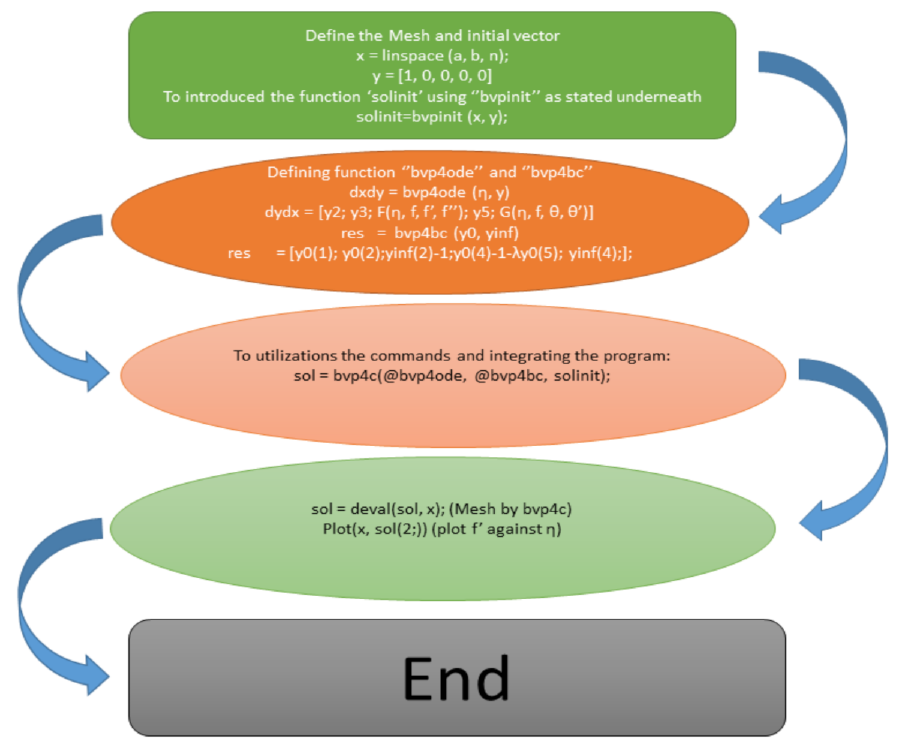
Figure 2. Disruption flow chat of numerical bv4c